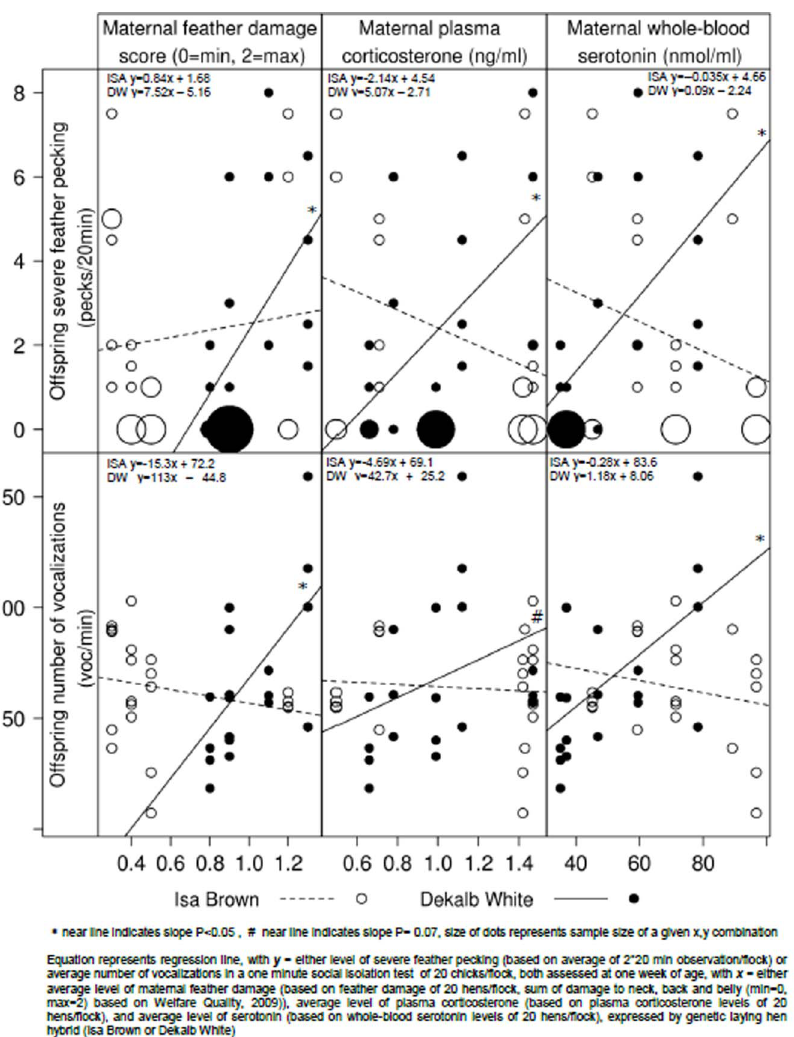
Figure 2. Average level of maternal feather damage [left panel], average level of maternal plasma-corticosterone [middle panel] and average level of whole-blood serotonin levels [right panel] with their offsprings’ average level of severe feather pecking at week one of age [upper panels] and the number of vocalizations in a social isolation at one week of age [lower panels].